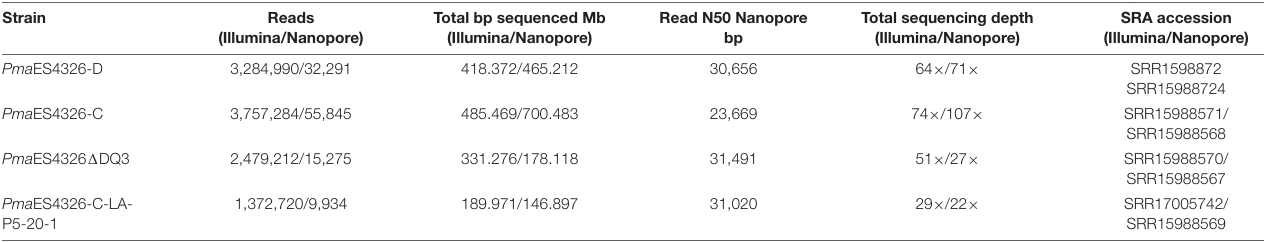
TABLE 1 | Sequencing of Pma ES4326 strains.